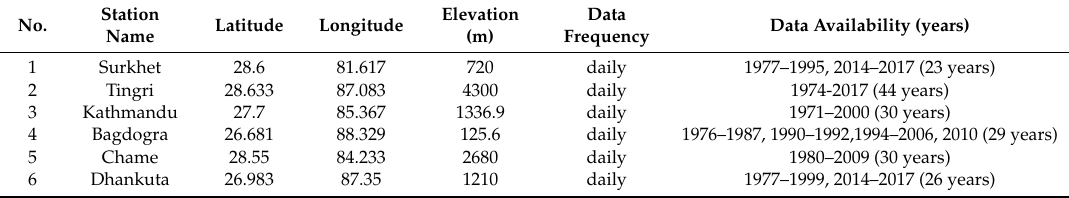
Table 1. Detailed information of the meteorological stations and the data